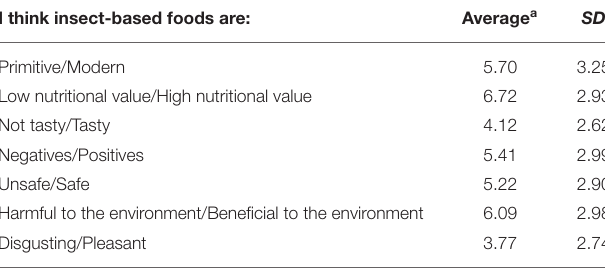
TABLE 4 | Perception regarding insect-based